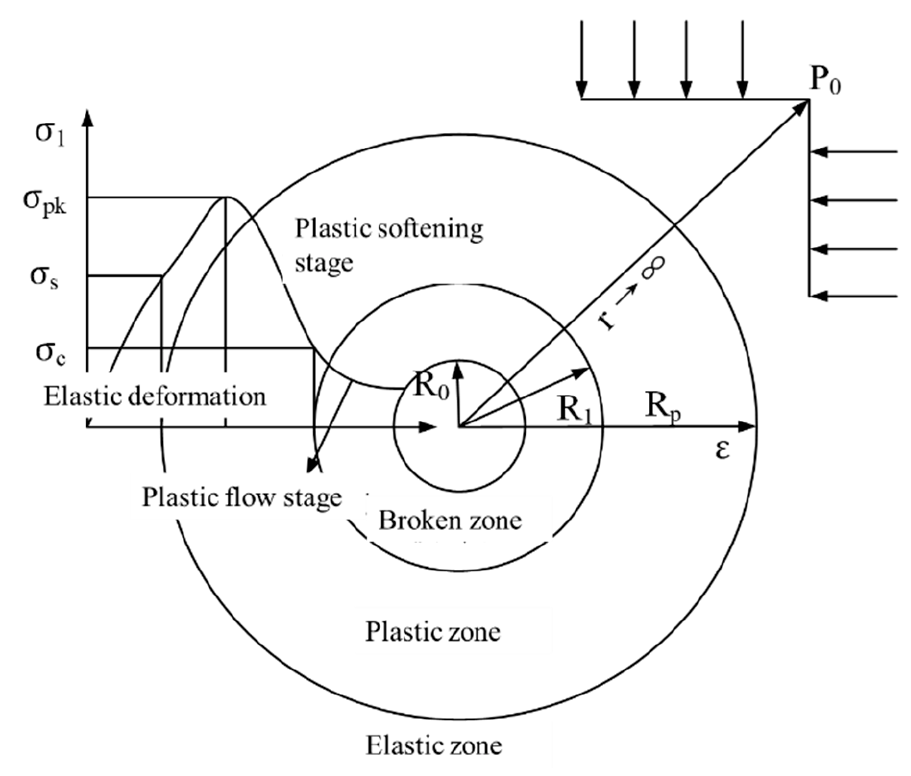
Figure 1. Surrounding rock zoning and rock stress–strain curve model of circular roadway. After tunnel excavation, stress on the surrounding rock is redistributed, resulting in unidirectional, bidirectional, and tridirectional states of the surrounding rock from the inside to the outside. At the same time, due to the different degrees of damage caused by the rock mass during the stress process, the rock mass is successively located in the fracture zone, the plastic zone, and the original rock stress zone along the radial direction of the roadway. Corresponding to the stress reduction zone, the stress increase zone, and the proto-rock zone, a relatively obvious hierarchical gradient failure pattern is